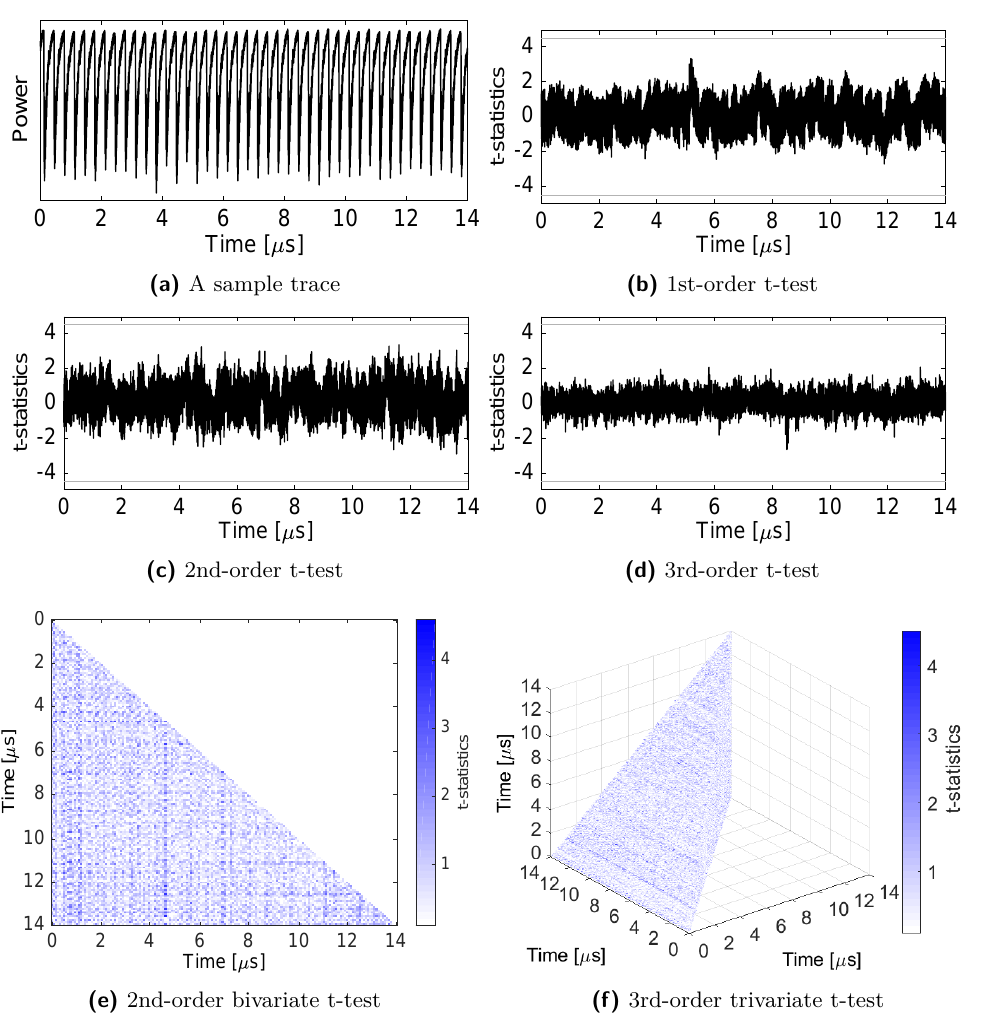
Figure 8: Experimental analysis of our masked Midori using 100 million